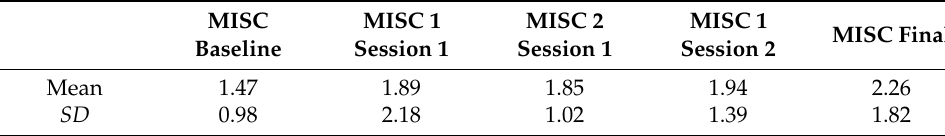
Table 7. Results of the MISC (0 (no symptoms)—10